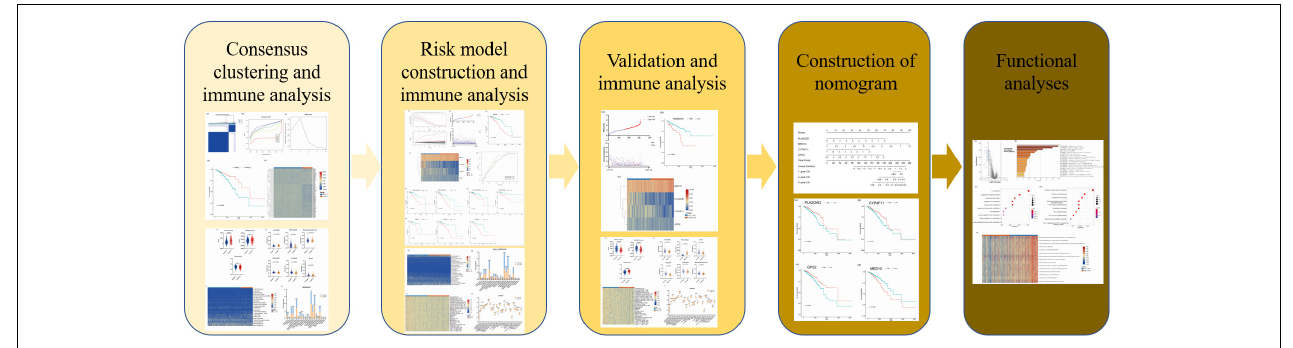
Table 2 . Each patient in both the training and validation cohorts was assigned a risk score, according to the following formula: risk score = ( − 0.2141 × PLA2G2D expression) + (0.52944 × MED10